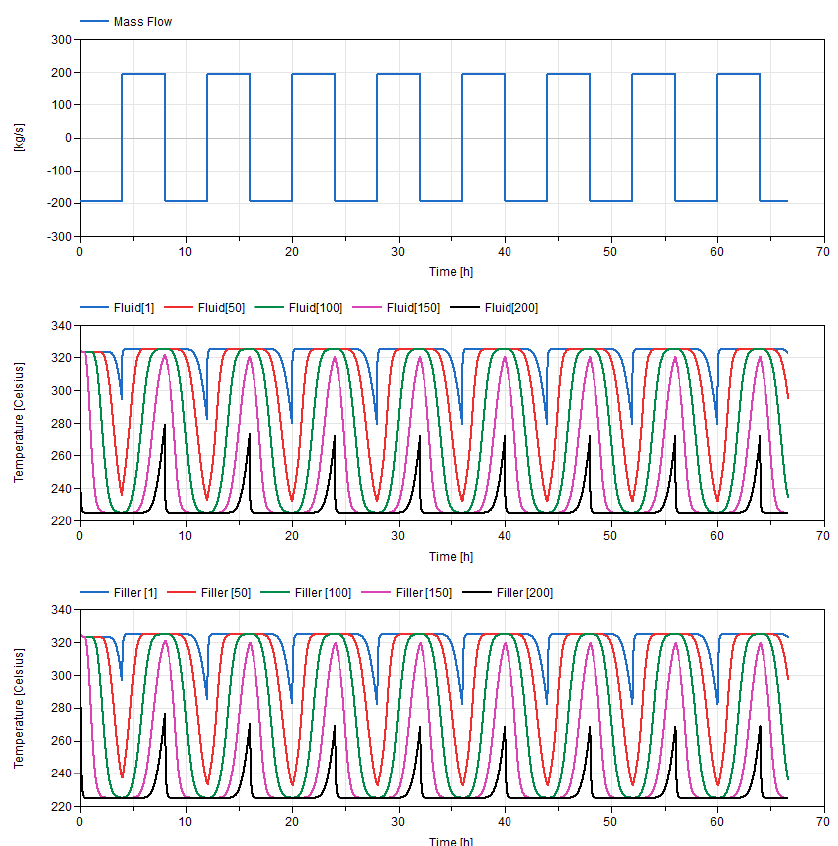
Figure 4. Periodic charging and discharging thermocline test.